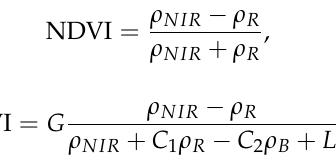
Figure 3. Monthly average precipitation.